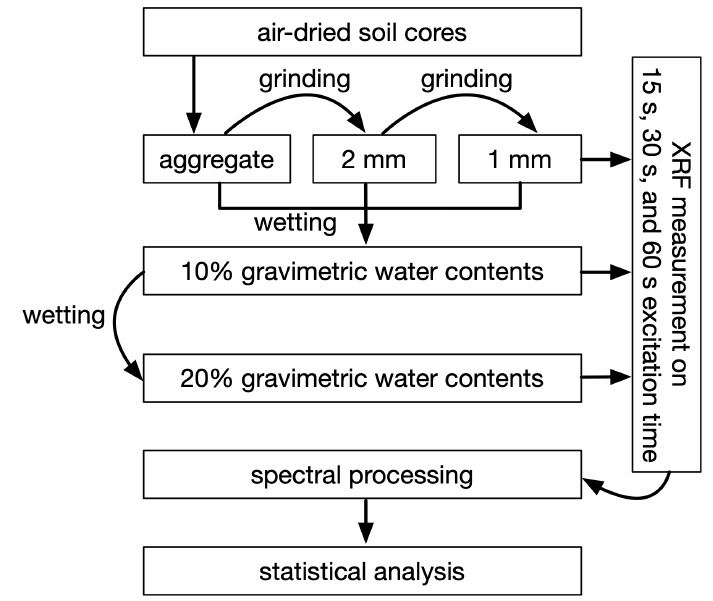
Figure 2. Flowchart of the